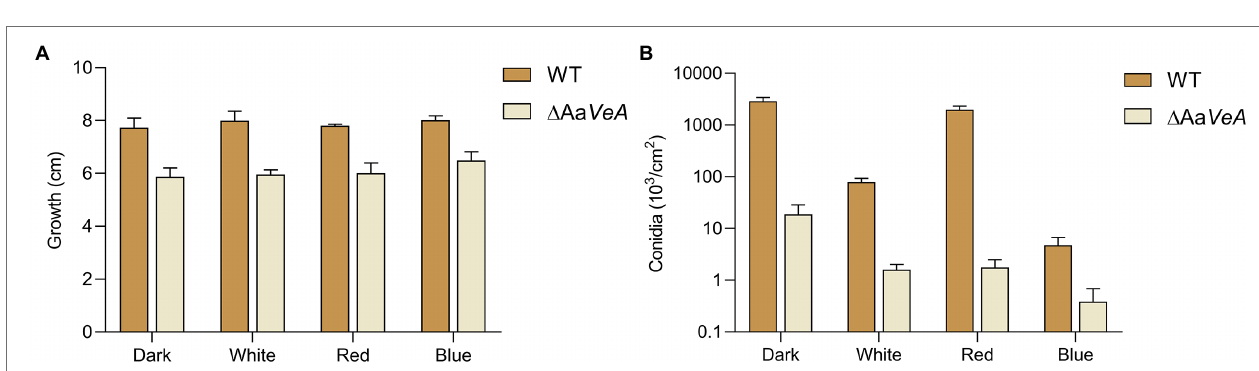
FIGURE 2 | Mycelial growth (A) and conidia formation (B) of WT and Δ Aa VeA strains. The colony diameter of WT and Δ Aa VeA strains cultured on PDA medium was separately measured. Accordingly, the conidia were washed and determined using the